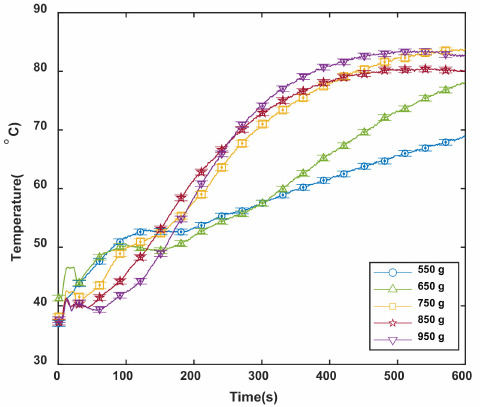
Figure 8. Variation in compressor discharge temperature over time with refrigerant charge